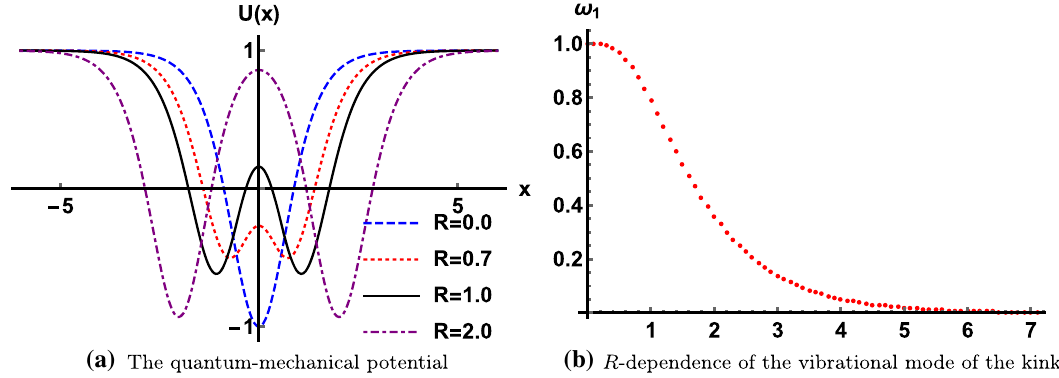
Fig. 4 a The quantum-mechanical potential (34), and b R -dependence of the vibrational mode’s frequency